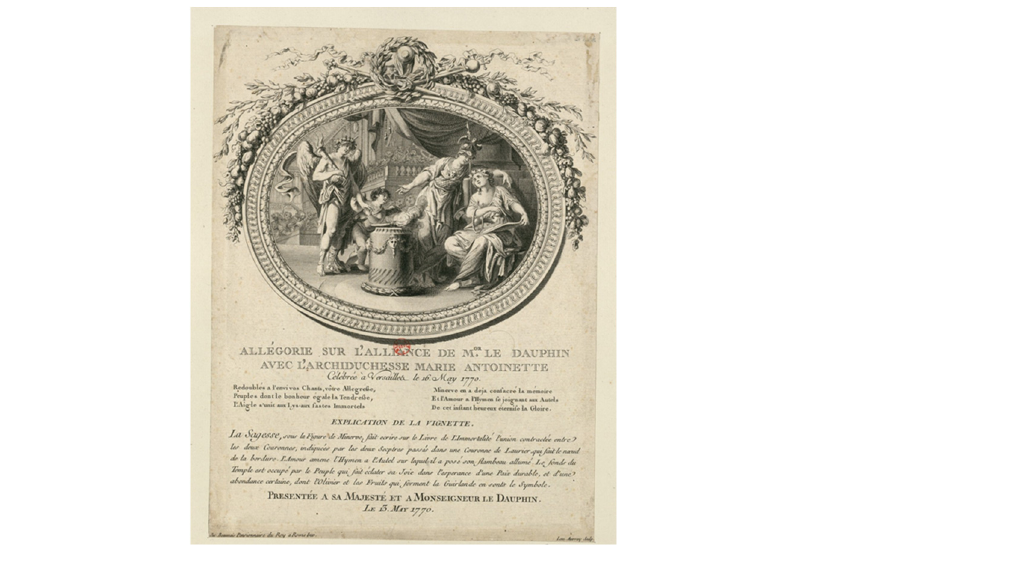
Figure 10. Pierre-Laurent Auvray (France, 1736–1781), after Jacques-Philippe de Beauvais (France, 1739–1781), Allégorie sur l’Alliance de Mgr le Dauphin avec l’Archiduchesse Marie-Antoinette, Célébrée à Versailles , 16 May 1770, Engraving, 16 cm × 19 cm, Bibliothèque Nationale de France, Département Estampes et Photographie ; Collection De Vinck (histoire de France, 1770–1871).